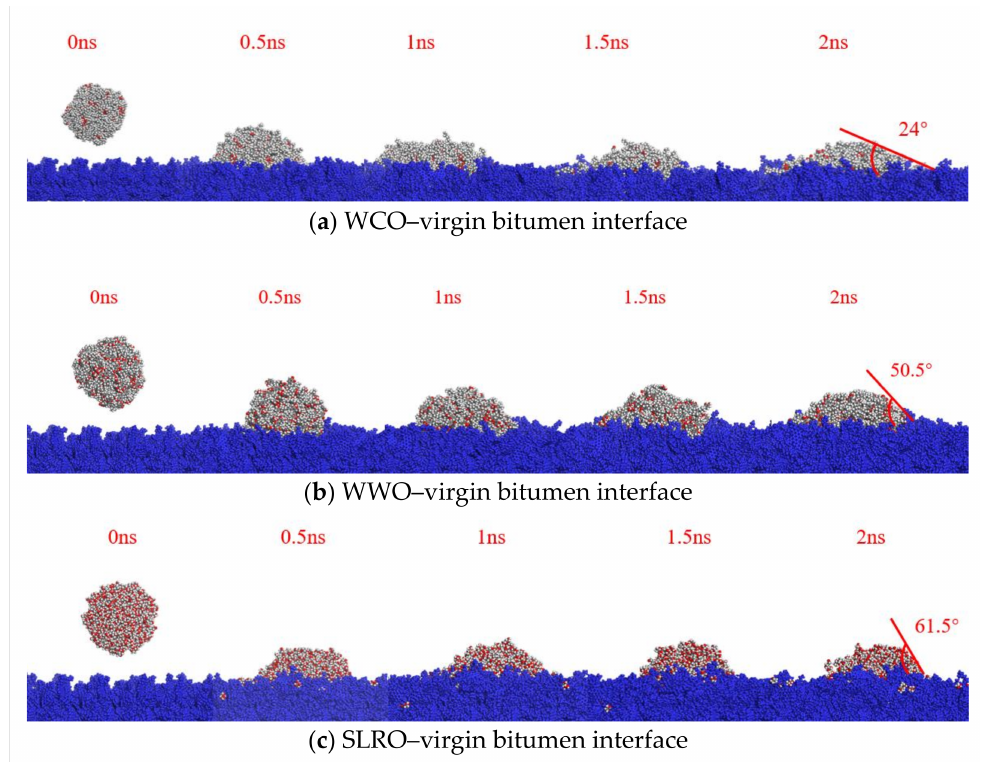
Figure 1. Wetting process of bio-oils nano-droplets on virgin bitumen surface at 408.15 K. Table 1. Contact angles measured by MD simulation and laboratory experiment at 408.15 K.